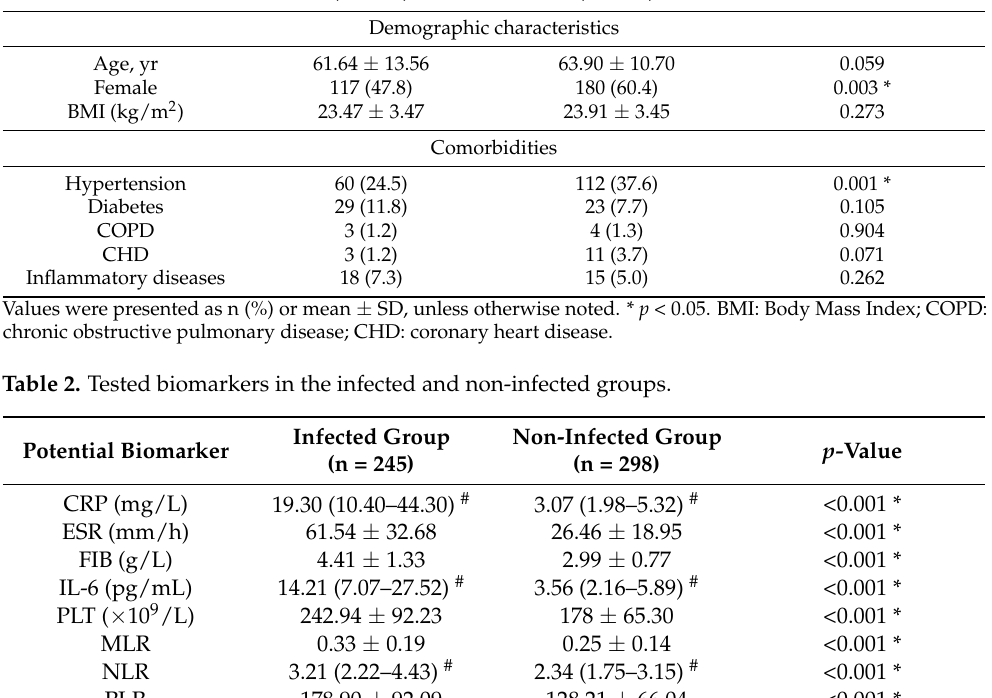
Table 2. Tested biomarkers in the infected and non-infected groups.